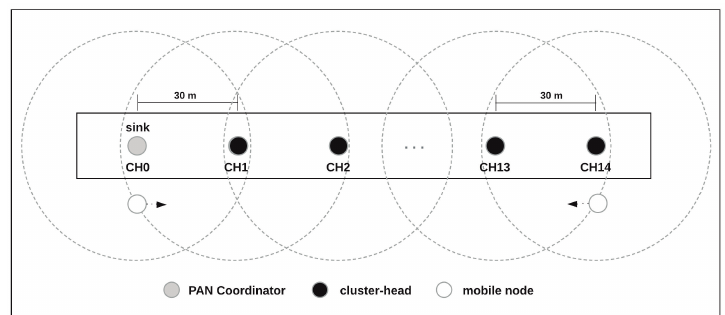
Figure 6. Communication